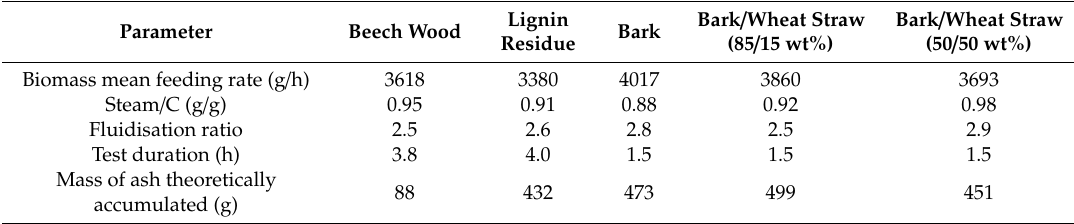
Table 2. Conditions of the fluidised bed gasification